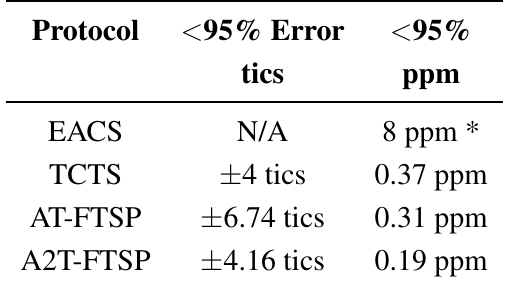
Table 7. Comparative results. EACS, Environment-Aware Clock Skew Estimation and Synchronization for WSN; TCTS, Temperature Compensated Time